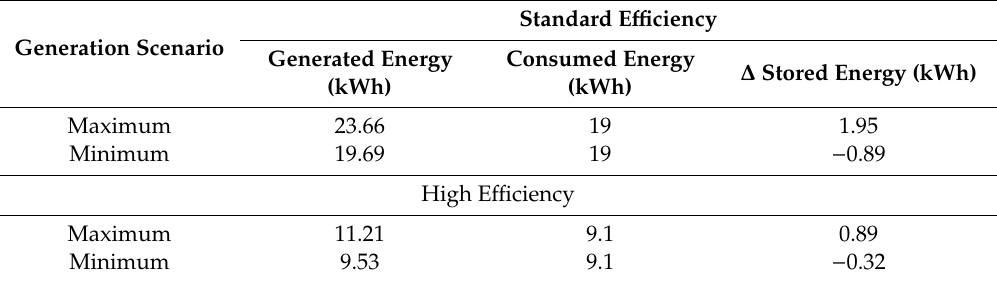
Table 3. Generated, consumed and stored energy for both generation and load estimation scenarios.